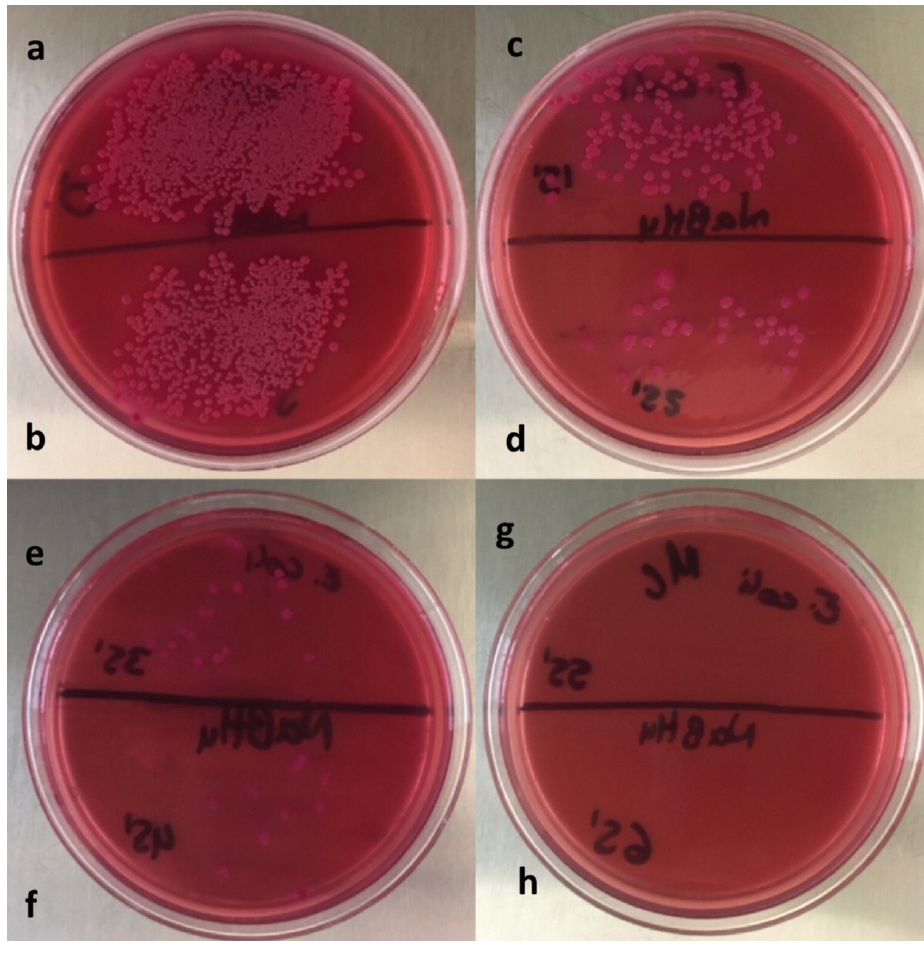
Figure 5. Photograph of plate with Escherichia coli and MacConkey as agar incubated with 5% Ag/Bovine bone powder at different times. Minimum inhibitory concentration (MIC) of 7.5 µg/mL ( a ) sample without support, ( b ) 5, ( c ) 15, ( d ) 25, ( e ) 35, ( f ) 45, ( g ) 55, and ( h ) 65 min after adding the Ag/bone system.